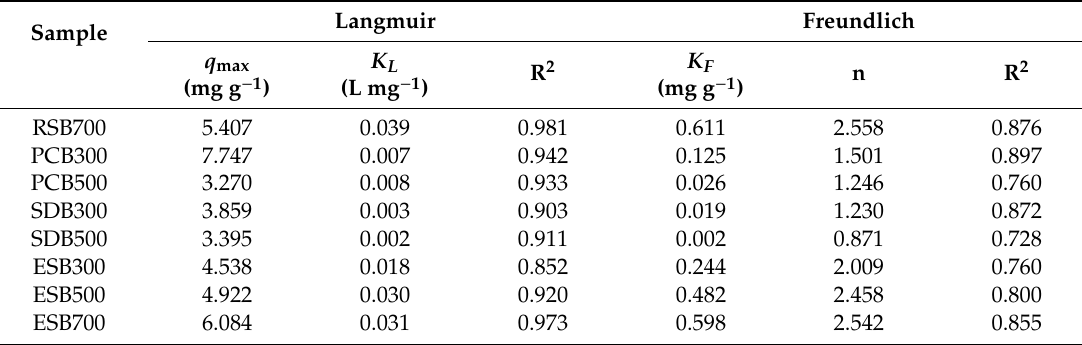
Table 4. Parameters of P adsorption isotherms of di ff erent biochars. Langmuir Sample